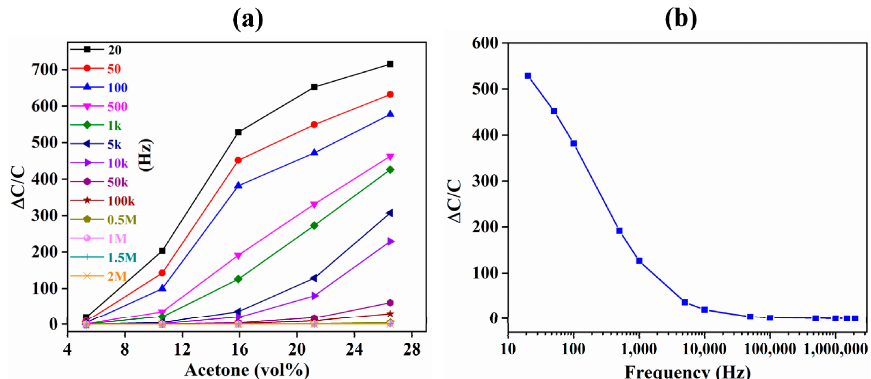
Figure 11. Effect of alternating current (AC) drive frequency on the sensitivity of the ZIF-8-coated IDE-based capacitive acetone sensor. ( a ) Sensitivity response of the sensor to acetone at various AC drive frequencies (20 Hz to 2 MHz). ( b ) AC drive frequency vs. sensitivity of the sensor at 15.9 vol % acetone.